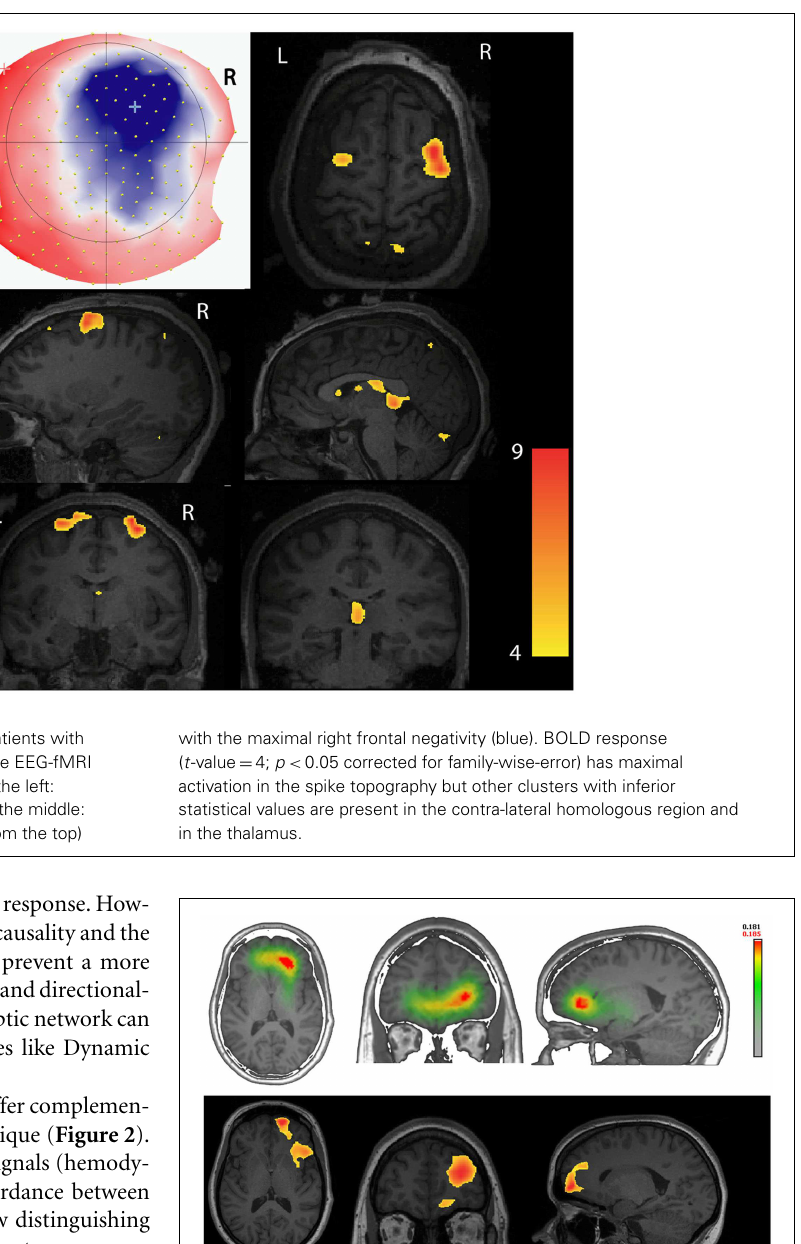
FIGURE 2 |Techniques using different types of signal are concordant in localizing the epileptic focus in a patient with right orbito-frontal focal cortical dysplasia . On the top-line: ESI (256 electrodes, simplified realistic head model lSMAC, distributed inverse solution LORETA) performed on right frontal spikes (FP2-F8). On the bottom-line: EEG-fMRI performed on the same type of events recorded inside the scanner.